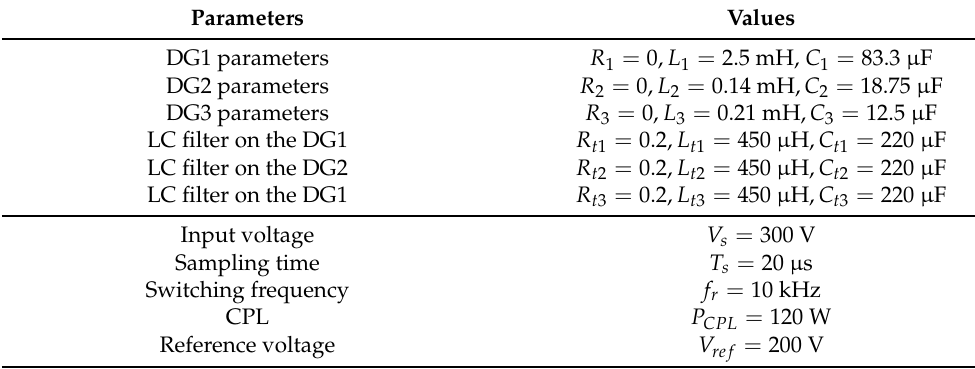
Table 2. Parameters of the test system.